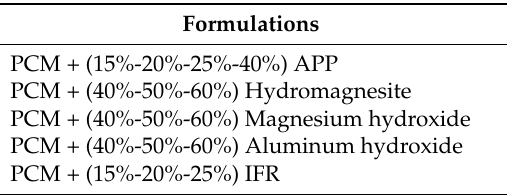
Table 3. Flame retardant